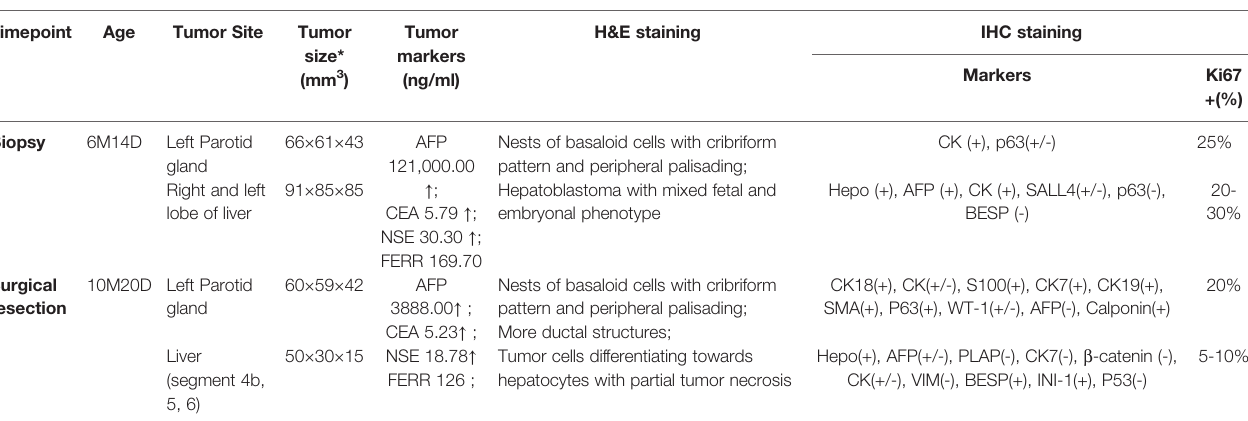
TABLE 1 | Clinical information and immunohistochemical